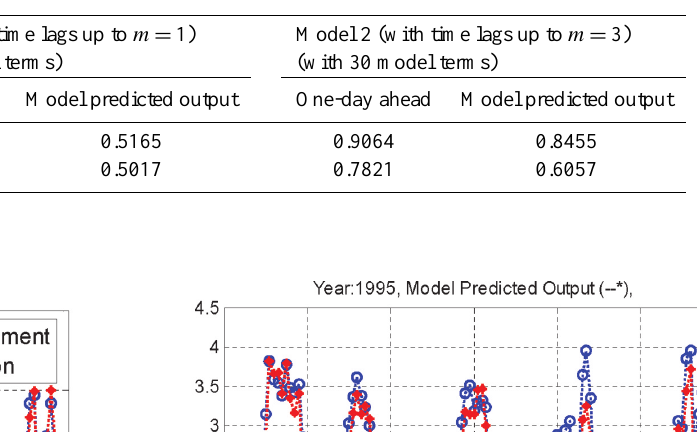
Table 1. Model prediction performance measured with the prediction efficiency (PE).